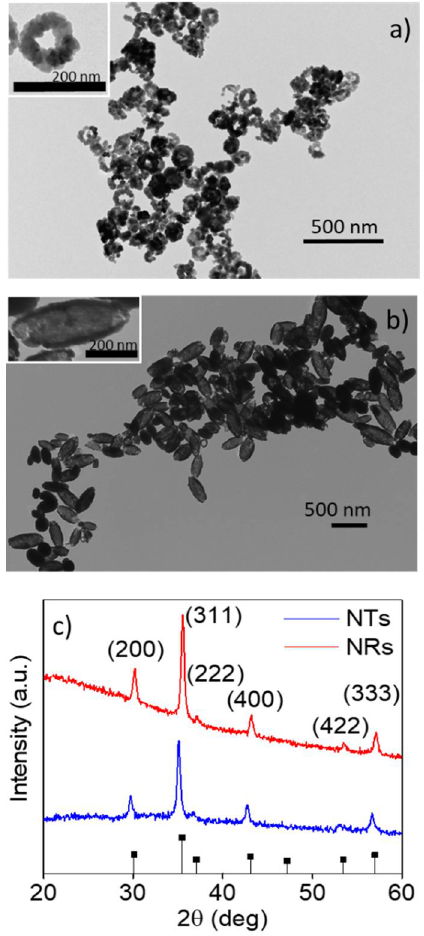
Figure 1. TEM images of ( a ) the iron oxide NRs and ( b ) NTs. In the insets, zoom-in images of a single NR and NT are included. ( c ) XRD data of the iron oxide NRs and NTs. The lower patterns with black squares correspond with the JCPDS data for bulk Fe3O4 (JCPDS No. 19-0629). Table 1. Dimensions of the iron oxide NRs and NTs. The length corresponds to the “height” of the hollow cylinder and the difference between the inner and outer diameters gives the wall thickness. Length